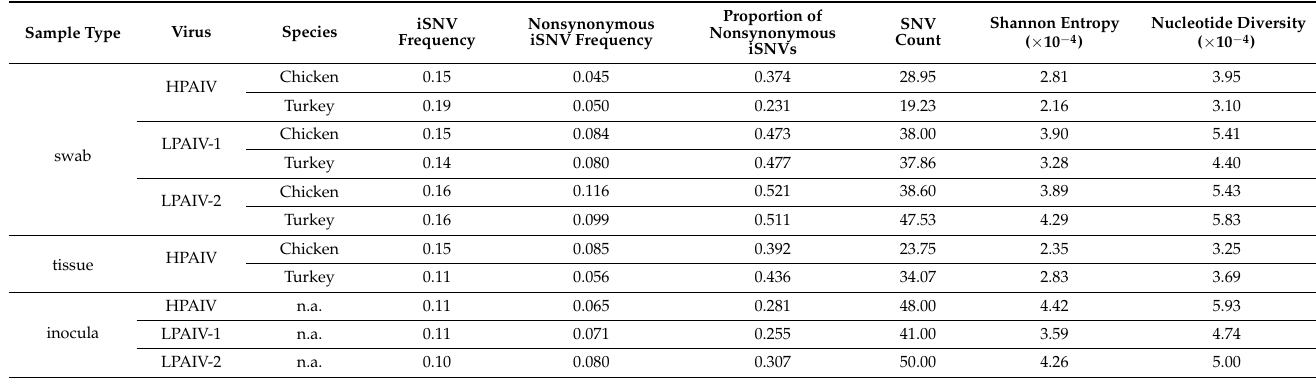
Table 3. Diversity measures in inocula and samples. The mean values for viral genomes from experimental samples were calculated for the indicated diversity measures. n.a. = not